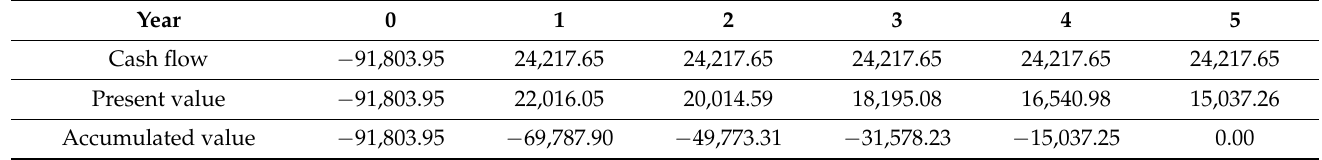
Table 6. Breakeven point